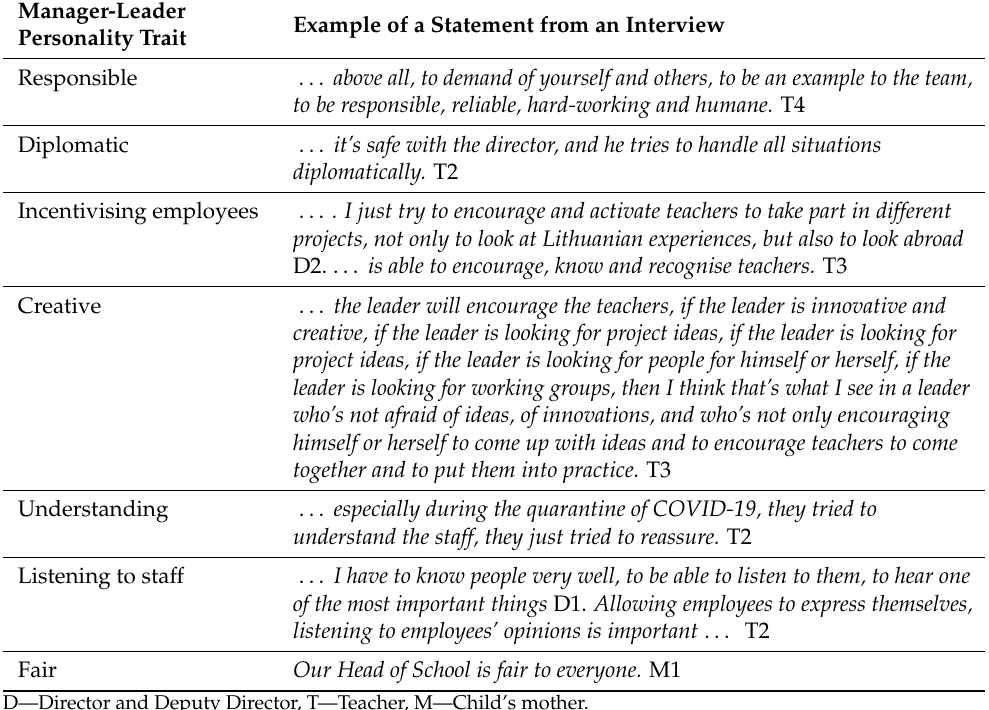
Table 4. Statements demonstrating the personality traits of a